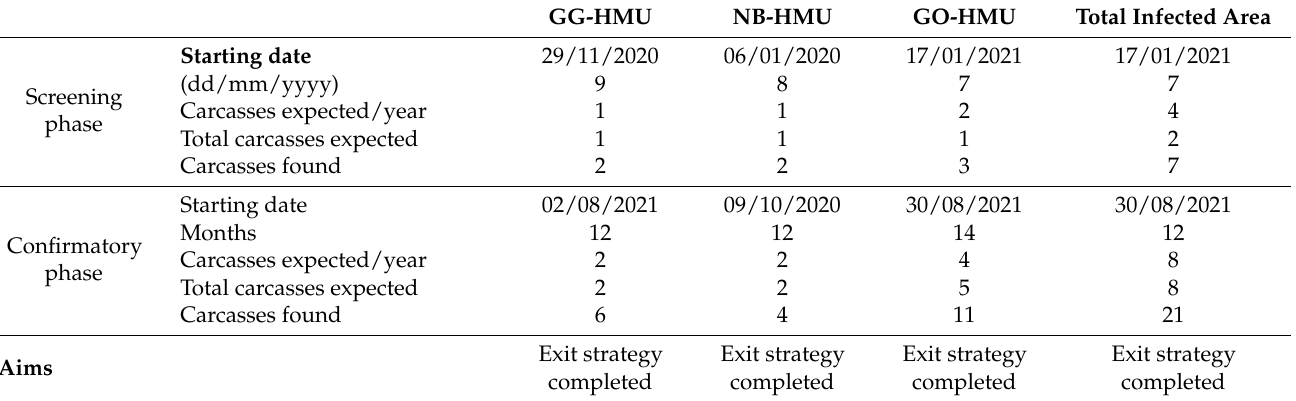
Table 7. Exit strategy indicators for the three HMUs that include the 2021 infected area, based on the 2% probability of a failure scenario and the estimated number of expected carcasses by the WBC-Counter tool using the wild boar hunted approach. Data are reported by the screening and confirmatory phases, including the starting date (last virus or seropositive young wild boar detection), duration (months), number of carcasses expected during one year, proportion of carcasses expected for the duration of the phase, and the number of carcasses